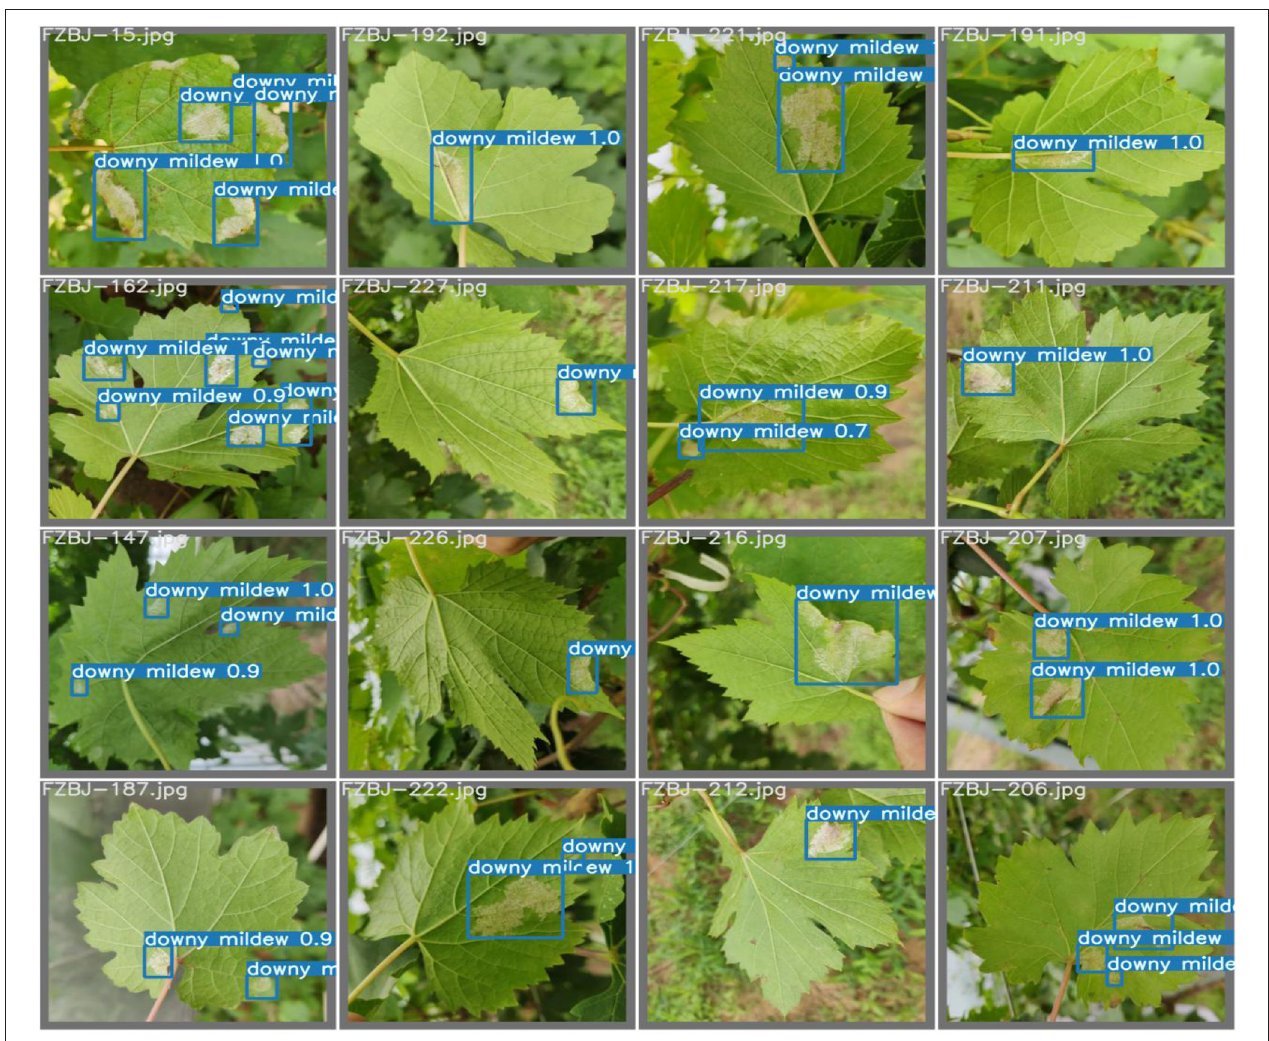
FIGURE 5 | Examples of YOLOv5-CA based GDM detection results.